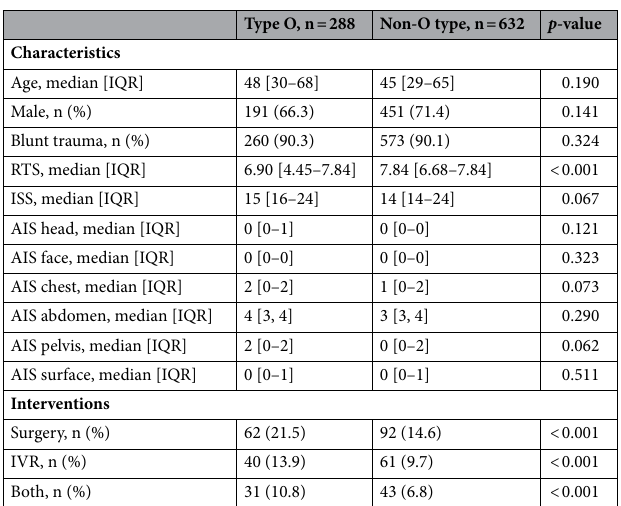
Table 3. Comparison of the characteristics of patients with blood type O versus those with other blood types. Categorical variables are expressed as numbers (%), while continuous variables are presented as medians (25th–75th percentiles). RTS revised trauma score, ISS injury severity score, AIS abbreviated injury scale, IQR interquartile range, IVR interventional radiology.